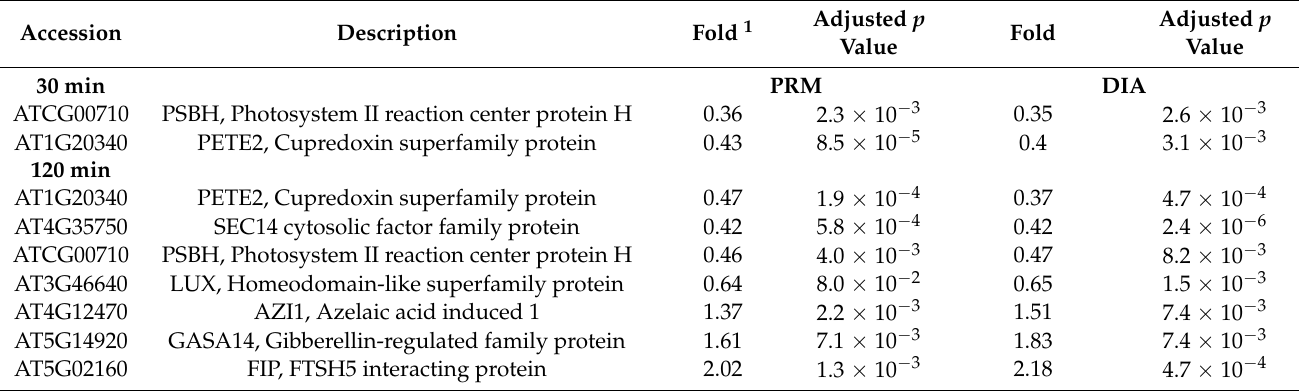
Table 1. Cold-responsive proteins identified from global proteome study and verified with